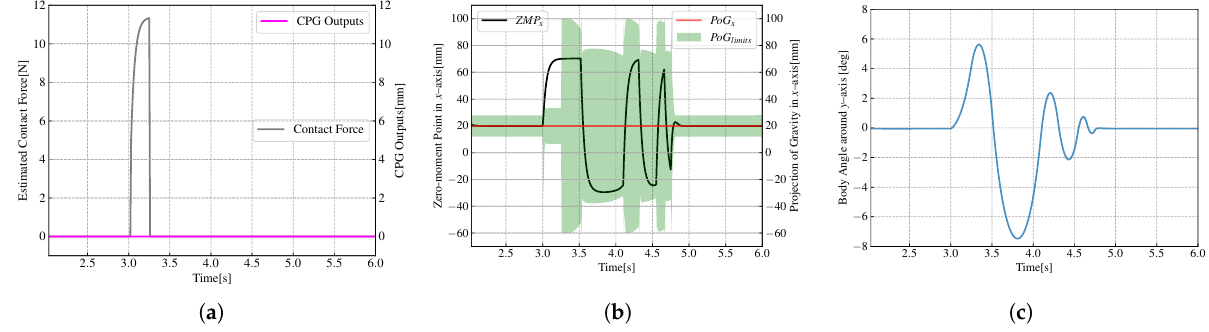
Figure 6. Variations of variables when the robots standing on double feet without CPG. ( a ) Variations of contact force and CPG output. ( b ) Variations of ZMP, the estimated projection of gravity (PoG) and the limit of PoG. ( c ) Variations of body